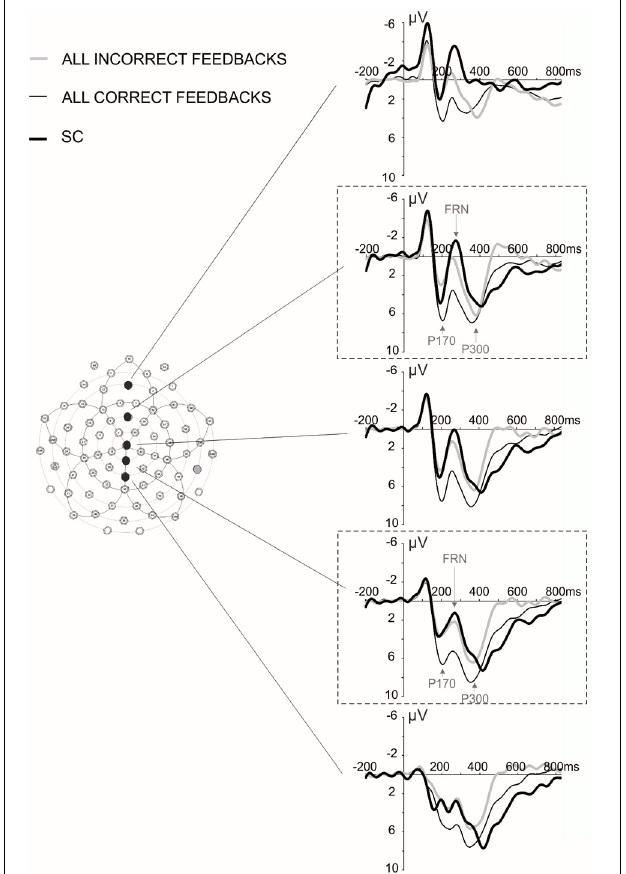
FIGURE 2 | ERPs elicited by all correct, all incorrect feedback, and SC at midline electrodes Fz, FCz, Cz, PCz, and Pz. The dashed line frames indicate the electrode of interest, FCz and PCz. Arrows indicate the peak of the three potentials (P170, FRN, and P300) that were considered in our analysis.